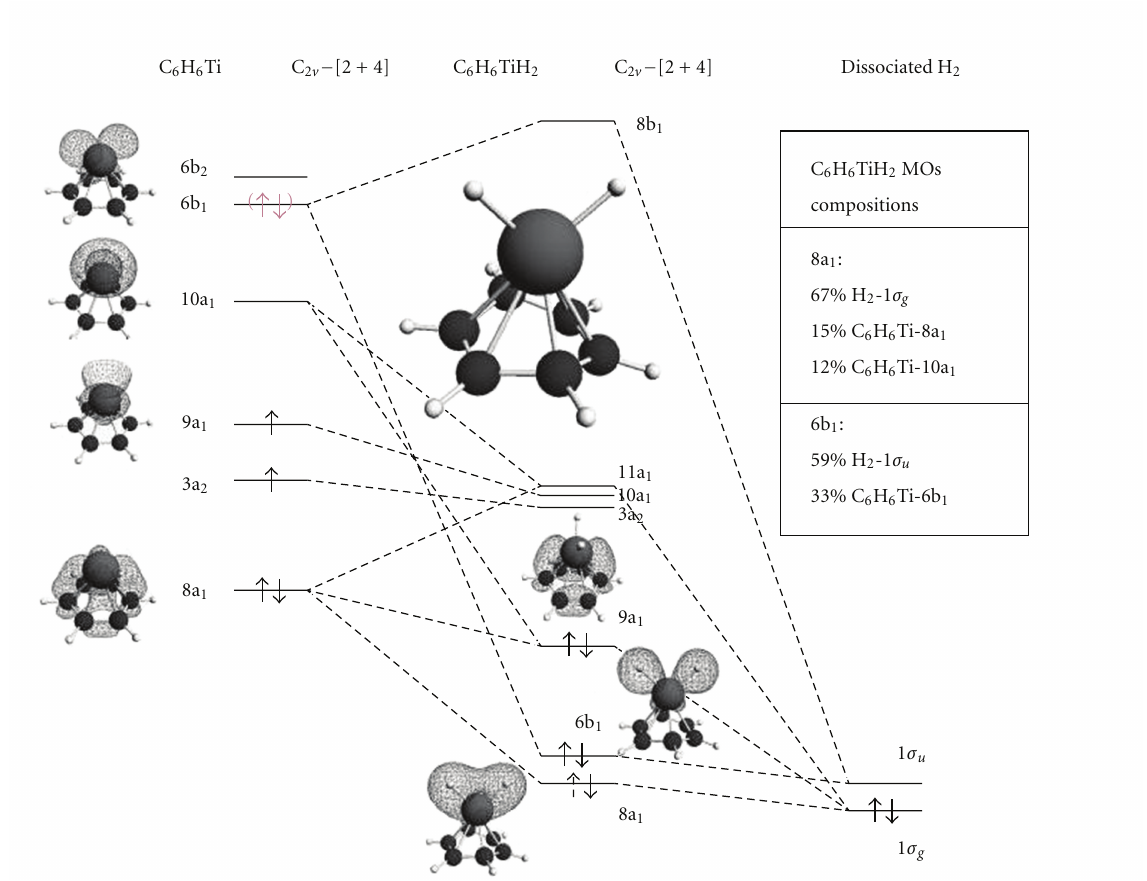
Figure 5: MO diagram for the C 6 H 6 Ti-H 2 dissociative interaction. Hydrogen, carbon, and titanium atoms are shown in white, dark grey, and light grey, respectively.